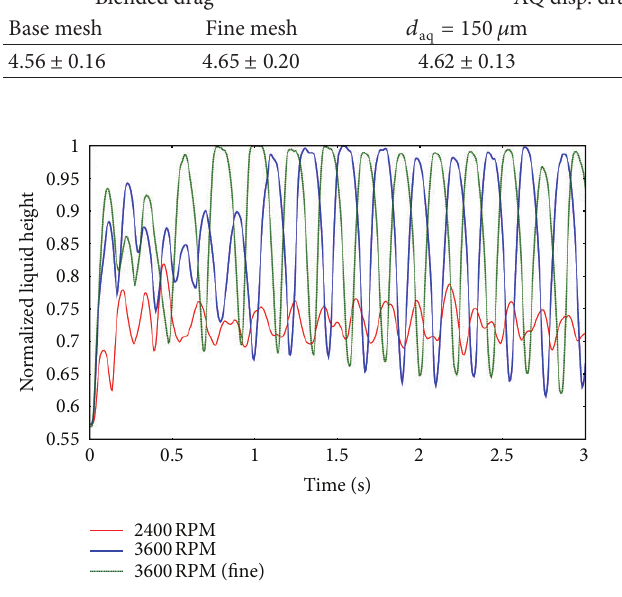
Figure 12: Plot of liquid height for the base case mesh at 2400 RPM and 3600RPM and the fine mesh at 3600